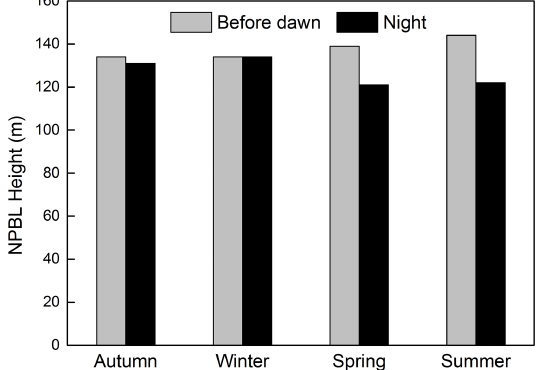
Figure 3. Averaged NPBL height in each season (before dawn 01:00–07:00; at night: 19:00–24:00GMT + 8:00).